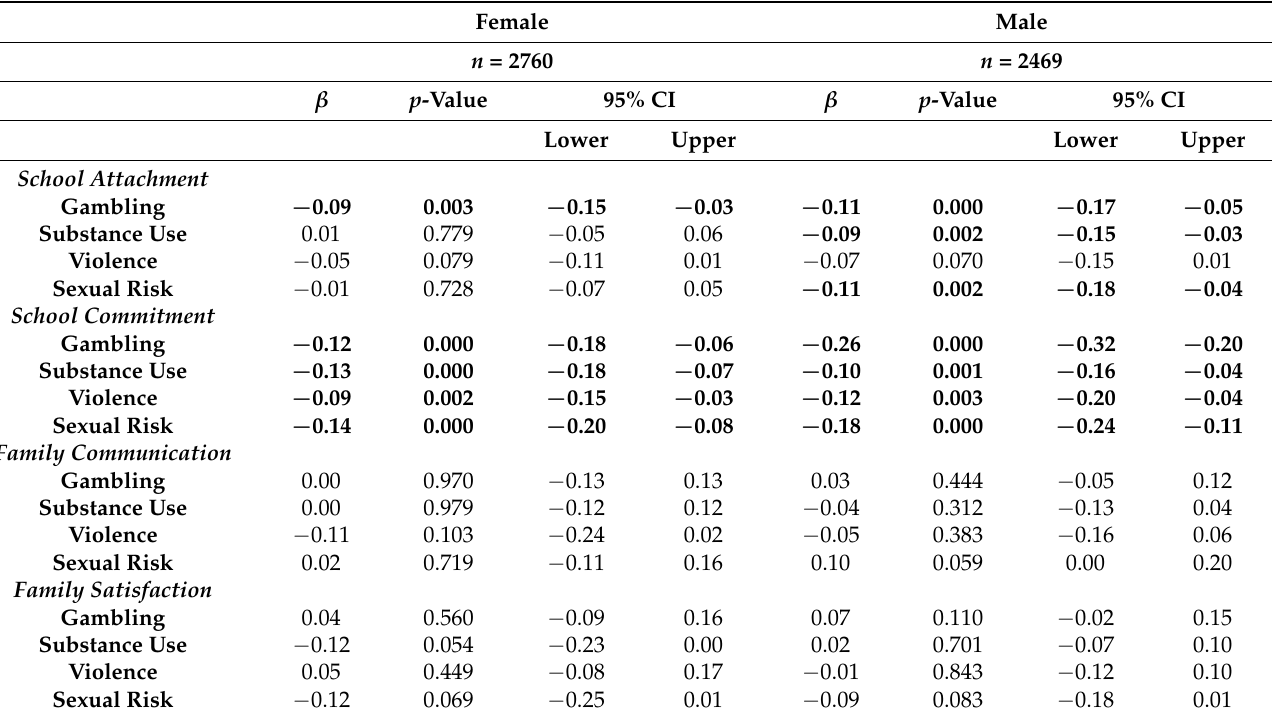
Table 3. Results of structural equations examining the association of family and school protective factors with female and male students’ gambling, substance use, violence, and sexual risk behavior in available subsample. Female Male n = 2760 n =